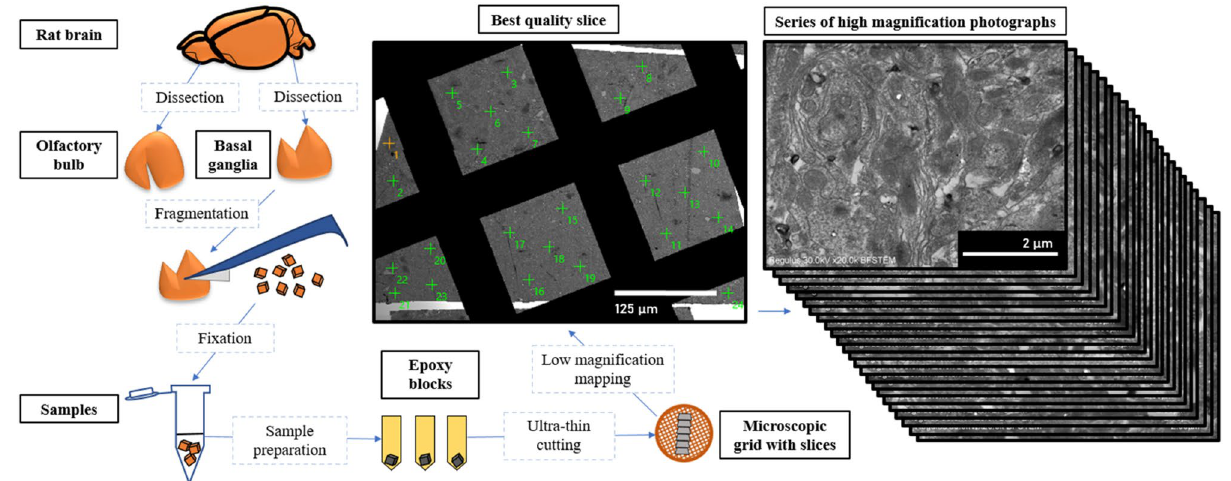
Figure 10. Sampling and sample preparation for electron